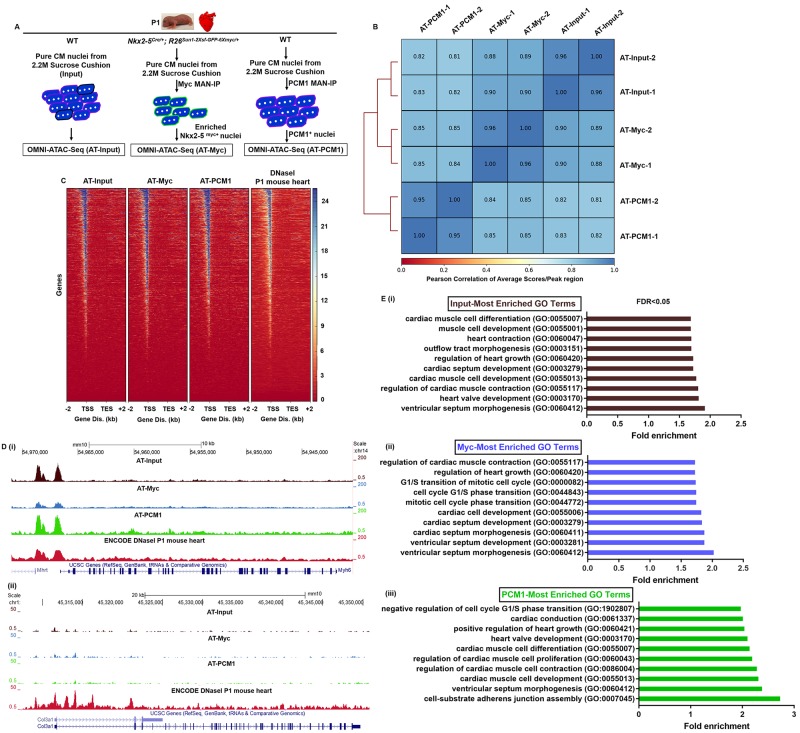
PAN-INTACT enables generation of high-resolution chromatin accessibility maps.A) Schematic diagram of experimental setup. CM nuclei were isolated from WT and Nkx2-5Cre/+; R26Sun1-2xsf-GFP-6xmyc/+ P1 mouse hearts using 2.2M sucrose-cushion, an aliquot of which was used as the input sample. Remaining nuclei were subjected to MAN-IP using a Myc or PCM1 antibody. Chromatin accessibility maps were generated for each sample individually using the OMNI-ATAC-Seq protocol. B) Similarity matrix demonstrating high pairwise Pearson correlations for ATAC-Seq biological replicates and amongst different samples. C) Heatmap showing a high degree of overlap for accessible sites within input, PCM1, and Myc samples. As an additional comparison, DHS-seq data is shown for P1 mouse heart from the ENCODE dataset. Kb (Kilobases) D) Genome browser tracks for canonical markers of CMs (i, Myh6) and fibroblasts (ii, Col3a1) with ATAC-seq peaks for each sample and DHS-seq peaks for comparison. E) Gene Ontology (GO) analyses for annotated nearest neighboring genes surrounding ATAC-seq peaks from all 3 samples (i-iii) display terms related to cardiac growth and function. Displayed results represent GO terms only with False Discovery Rate (FDR) < 0.05.